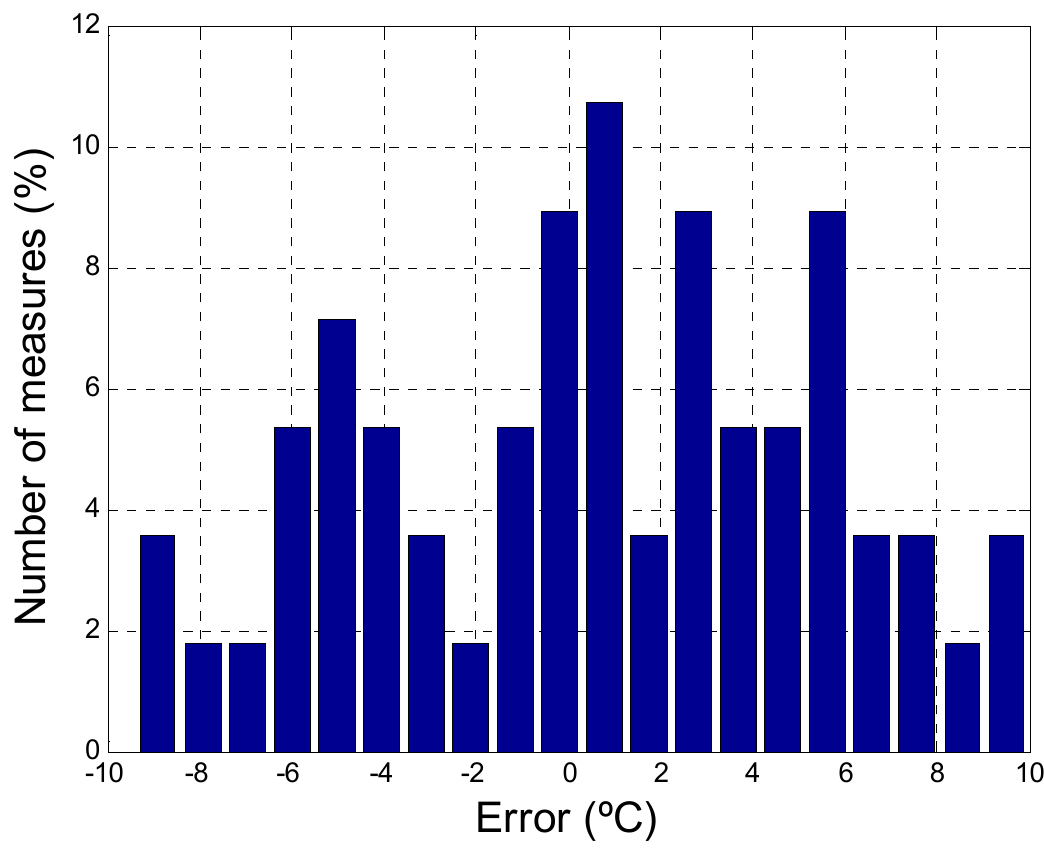
Figure 10. Temperature error histogram for all the experiment working points.